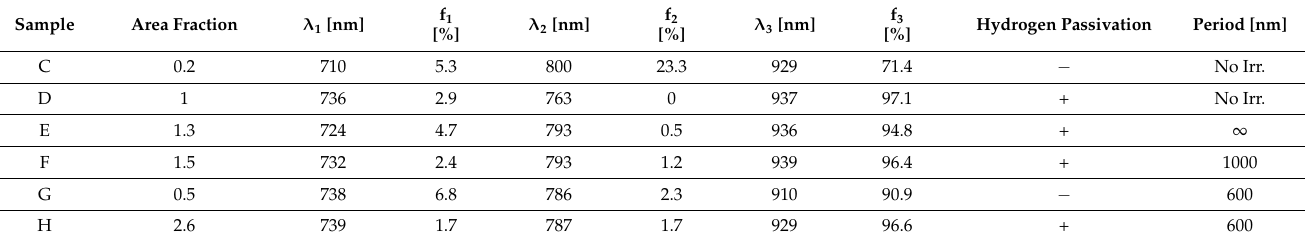
undergo a blue shift when comparing the data of the laser-treated sample with the data of the non-laser-treated sample. The blue shift of the main peak amounts to 19